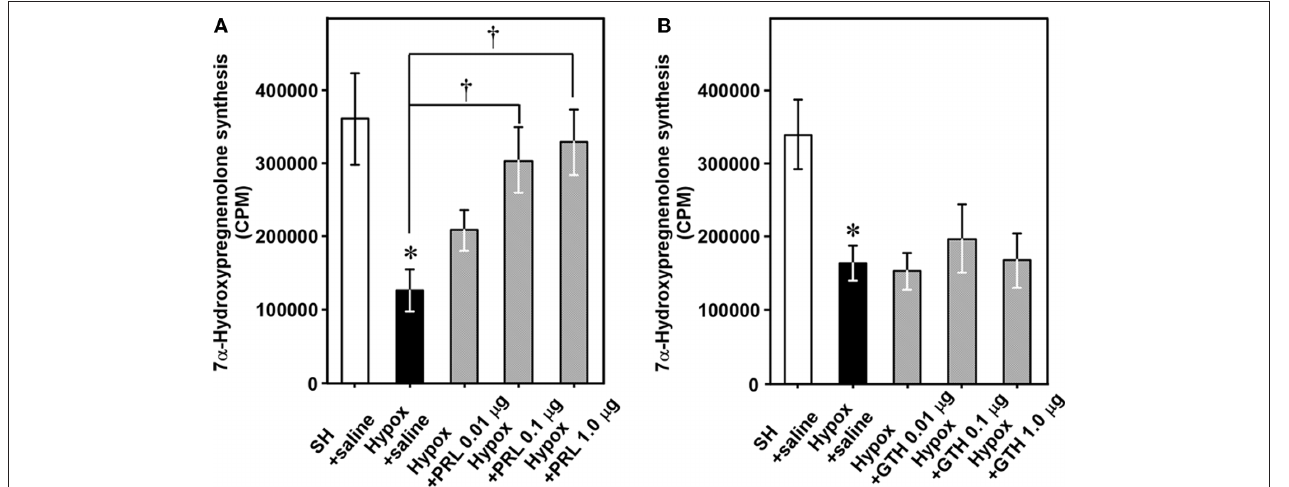
FigurE 8 | Effects of hypophysectomy (Hypox) and administration of PrL or gTH on 7 α -hydroxypregnenolone synthesis and concentration in the brain of breeding male newts. (A) Effects of Hypox and i.c.v. injection of various doses of PRL on 7 α -hydroxypregnenolone synthesis. (B) Effects of Hypox and